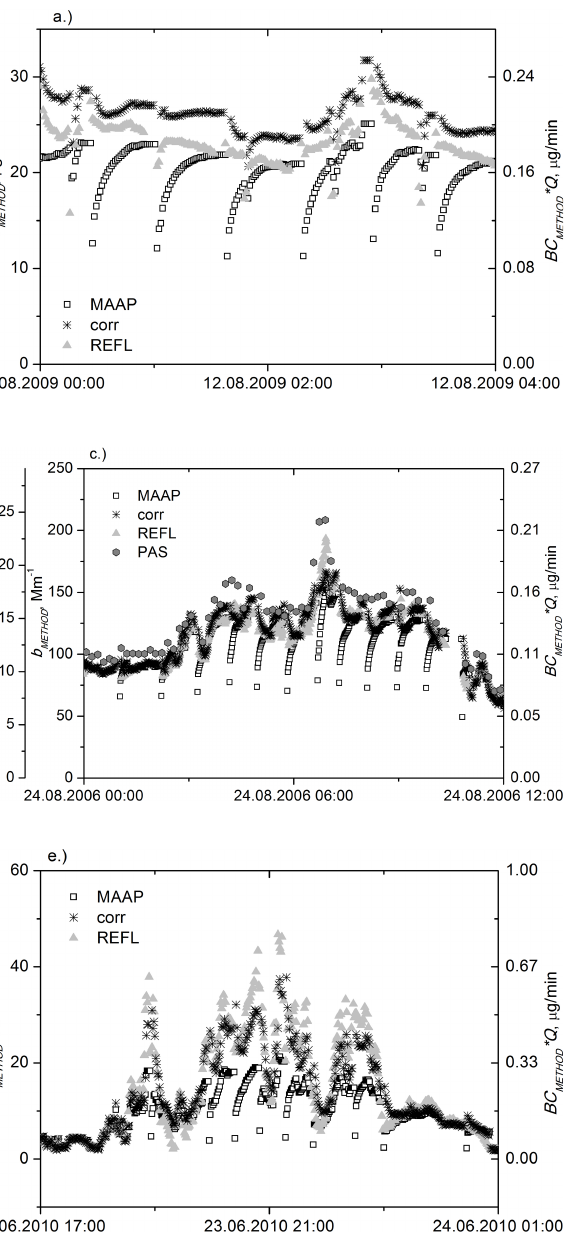
Fig. 5. Examples of the correction algorithm applied to the datasets from Gual Pahari (a, b) , Beijing (c, d) , and Welgegund (e, f) . In panels (b) , (d) , and (f) the datasets from different methods are compared against the reflected BC signal, BC REFL . Lines in these figures are linear fits to data. BC in Beijing was measured with 1:1 dilution. For Beijing, the absorption coefficients b METHOD at 532nm from the PAS and those derived from the MAAP (see text for details) are also